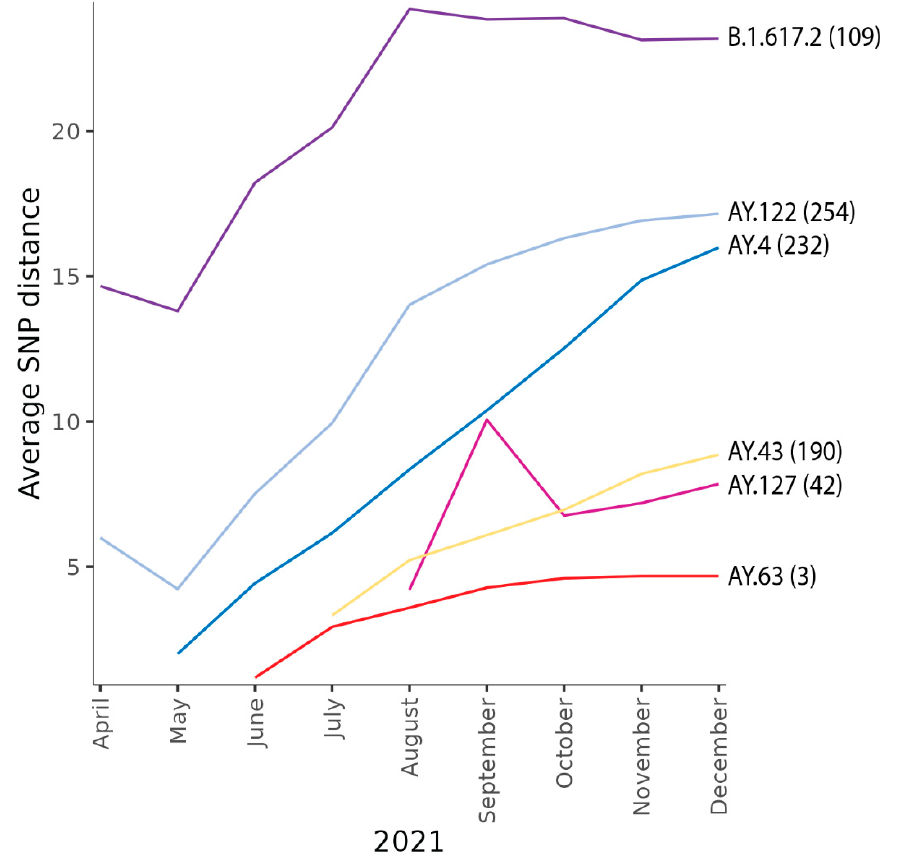
Figure 4. Lineage dynamics. Cumulative average pairwise SNP distances plotted over time for the Norwegian AY.63 sequences and the most frequent co-circulating lineages. To the right of each graph is the Pango lineage nomenclature for each of the lineages indicated with the estimated number of imports into Norway in parenthesis.